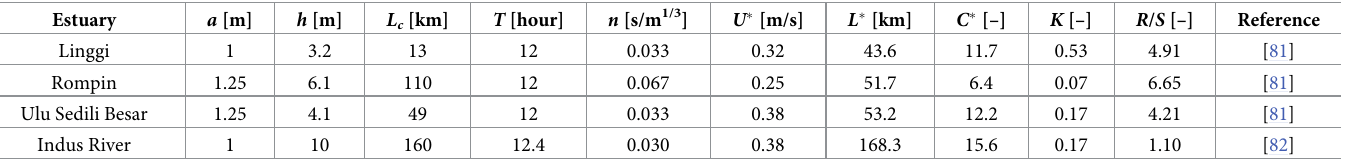
into the influences that drive tidal range patterns and where these changes are likely to occur. The results presented in Figs 3–7 may be potentially reproduced using existing analytical and semi-analytical solutions for tidal amplitudes (e.g., [28, 38]), though they do not consider bed slope (Fig 8). Here, results are presented for different estuary types, tidal ranges at the mouth, and river discharge conditions (e.g., no, low, medium, and high river discharge conditions). This analy- sis provides further understanding of the potential effects of river inflows and SLR on tidal range, which is an important indicator for tidal dynamics, sediment transport, water quality, and vegetation communities. The presented cases provide an overview of the typical estuarine tidal range responses to SLR, and the results of all cases are summarised in S1 Table. For all the provided result figures, blue, red, and green colours indicate the base case (no SLR), 1 m of SLR, and 2 m of SLR scenarios, respectively.